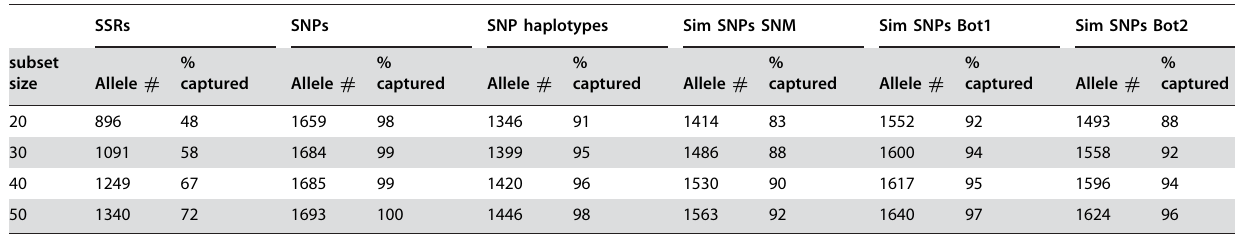
Table 5. Alleles captured by subsets of the data for different marker sets. .. ... .... ... ... .... ... ... .... ... ... .... ... ... .... ... ... .... ... ... .... ... ... .... ... ... .... ... ... .... ... ... .... ... ... .... ... ... .... ... ... .... ... ... .